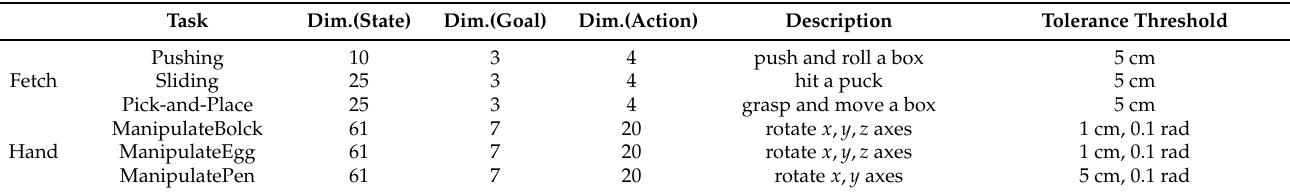
Table 2. Goal-oriented continuous control tasks for evaluating HER variants.